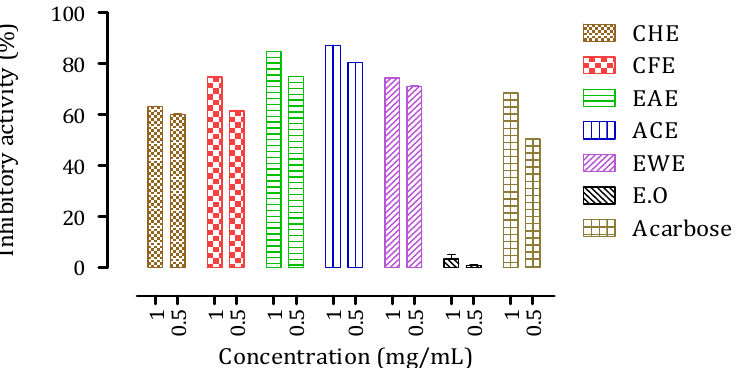
Figure 6. Inhibitory activity of C. aurantium peel extracts and Acarbose against pancreatic α -amylase in vitro for two extract concentrations, 0.5 mg/mL and 1 mg/mL.